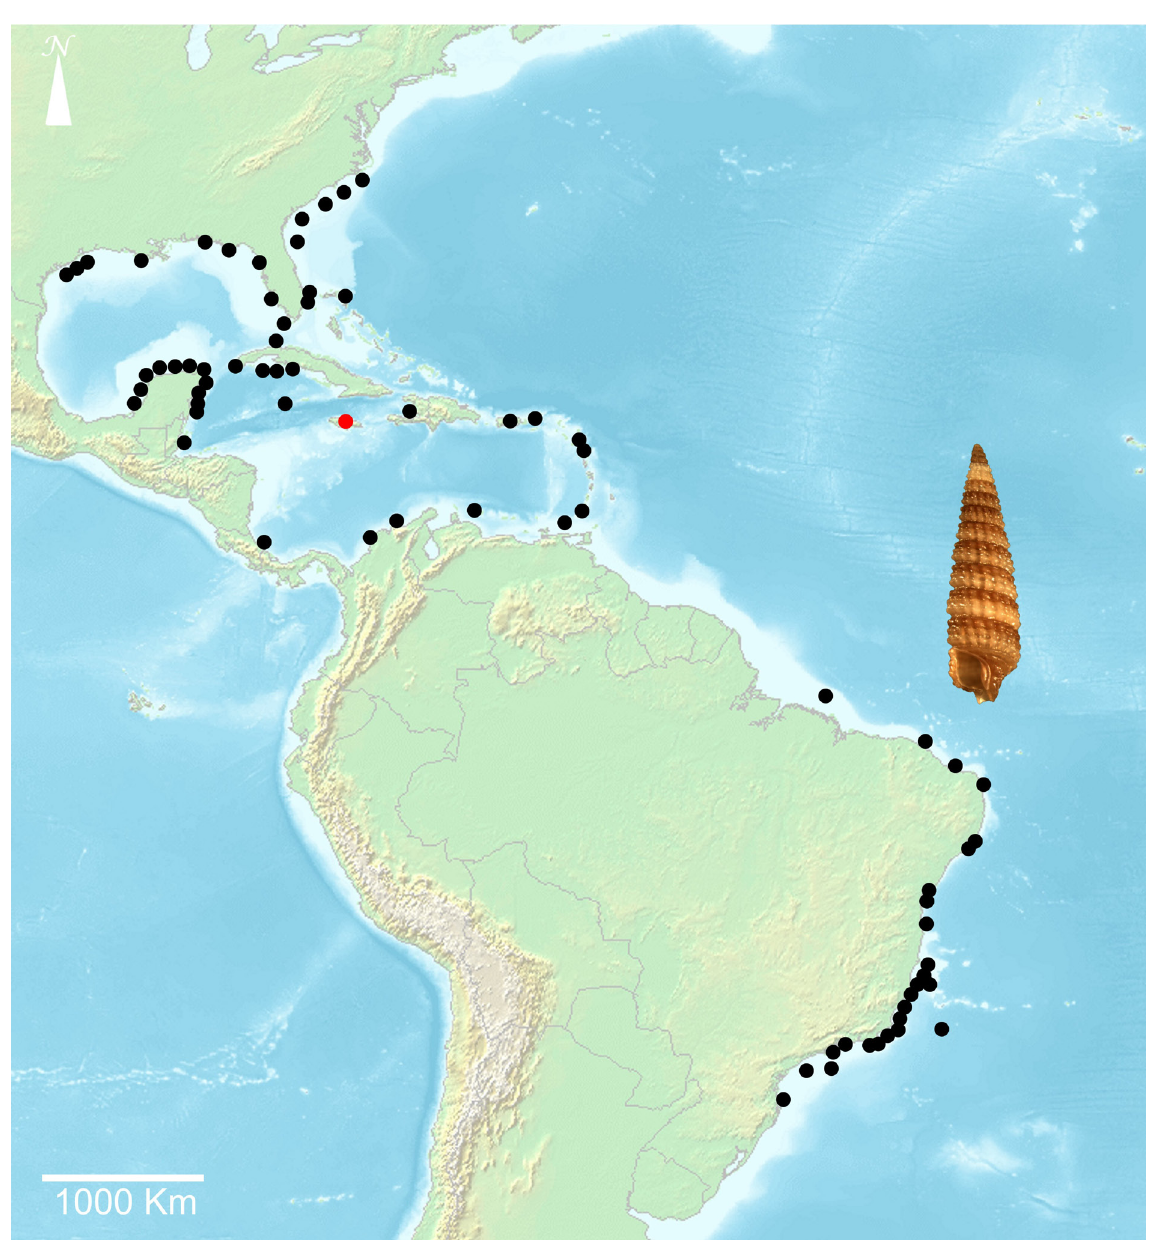
Fig. 65. Distribution map of Similiphora intermedia (C.B. Adams, 1850); red circle = type